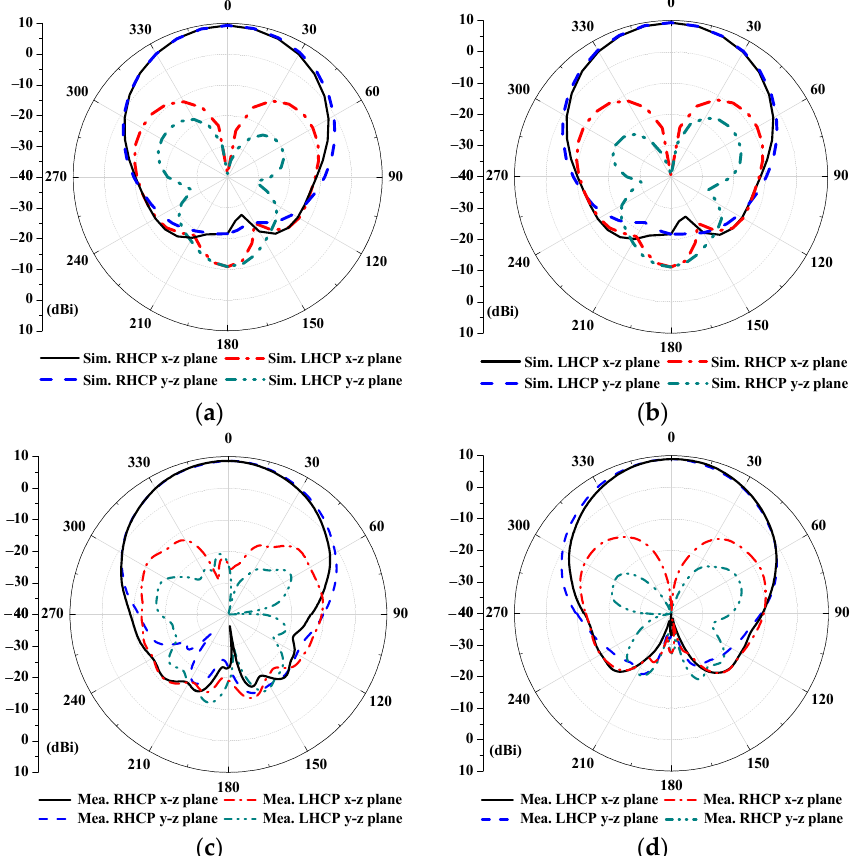
Figure 9. Radiation patterns of ( a ) RHCPA and ( b ) LHCPA in simulation; and ( c ) RHCPA and ( d ) LHCPA in measurement, at frequency 2.438 GHz and 2.37 GHz, respectively.